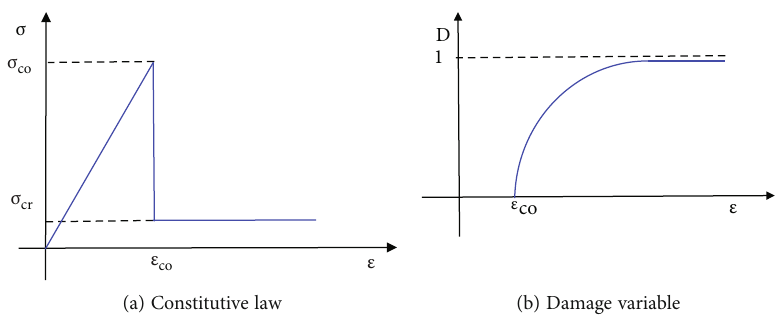
Figure 4: Constitutive law and damage variable in shear failure mode.